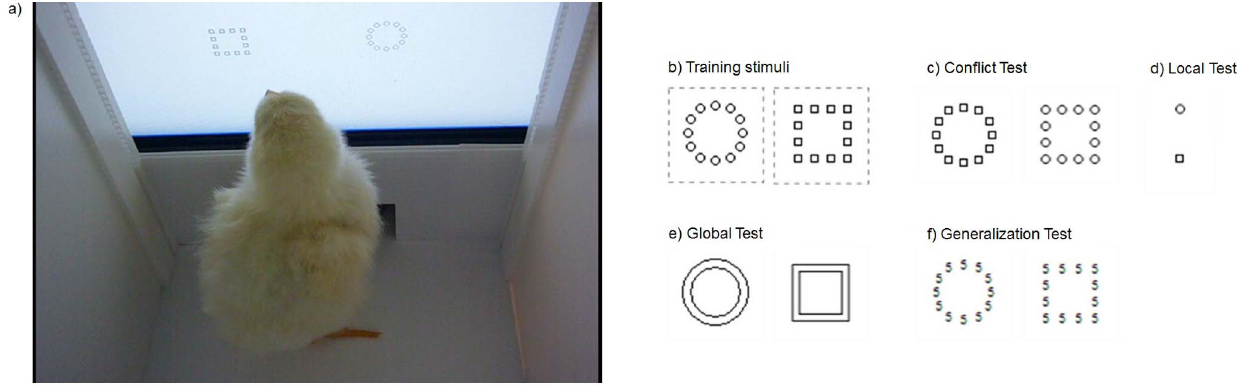
Figure 1. Chick within the apparatus and hierarchical stimuli. A picture of a chick during the training phase in front of the screen while choosing between the two hierarchical stimuli (a). Stimuli used during training (b). Circular configuration of 12 identical circles (left panel) and square configuration of 12 identical squares (right panel) used during training. The dotted lines show the bitmap area for all the stimuli and here shown for the training stimuli for representative purposes only. Stimuli used at Conflict test (c) - the local elements composing the training stimuli are swapped between configurations; Local test (d) - two single local elements of those composing the training stimuli; Global test (e) - two frames covering the global shape of the training stimuli; Generalization test (f) - the local elements composing the training stimuli are replaced with a series of local elements of a new type, a character 5.